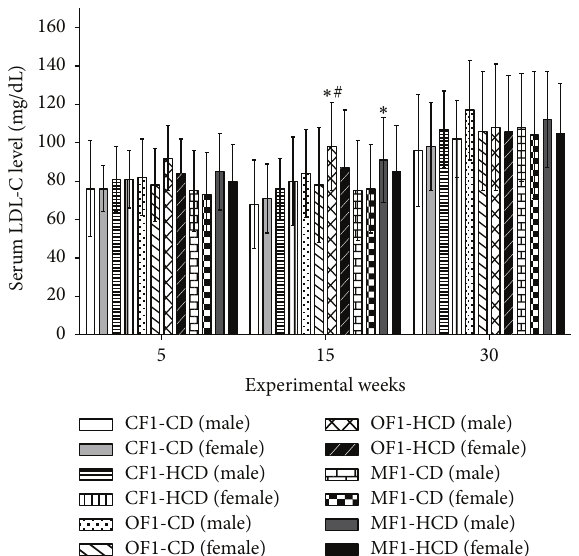
Figure 7: Serum levels of low-density lipoprotein-cholesterol (LDL- C) (mg/dL) of all study groups. Data are presented as mean ± SD ( 𝑛 = 10 ). CF1-CD: F1 offspring of control mothers under control diet, CF1-HCD: F1 offspring of control mothers under high-caloric diet, OF1-CD: F1 offspring of obese mothers under control diet, and OF1-HCD: F1 offspring of obese mothers under high-caloric diet; MF1-CD: F1 offspring of malnourished mothers under control diet and MF1-HCD: F1 offspring of malnourished mothers under high- caloric diet. The symbol ∗ indicates significant difference from CF1- CD by ANOVA ( 𝑝 < 0.05 ) and the symbol # indicates significant difference from CF-HCD by ANOVA ( 𝑝 < 0.05